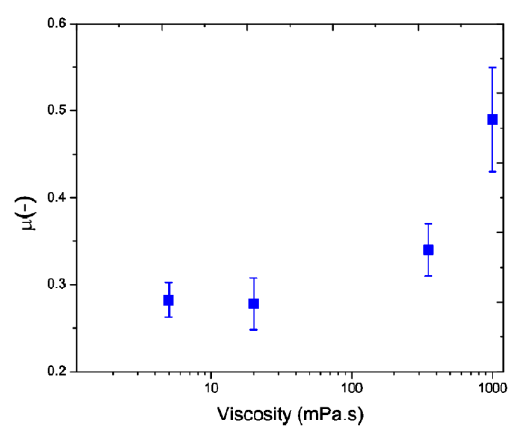
Fig. 2. Dynamic friction coefficient vs. viscosity, for different silicone oils as the interstitial liquid between glass beads. The values for the viscosities and surface tensions of the interstitial liquid are listed in Table 1. By increasing the viscosity, the friction coefficient increases too. We have increased the viscosity of the fluid with a constant levelling of surface tension. The results show that another factor other than fluid surface tension is effective on the system response to shear force, which increases the coefficient of friction